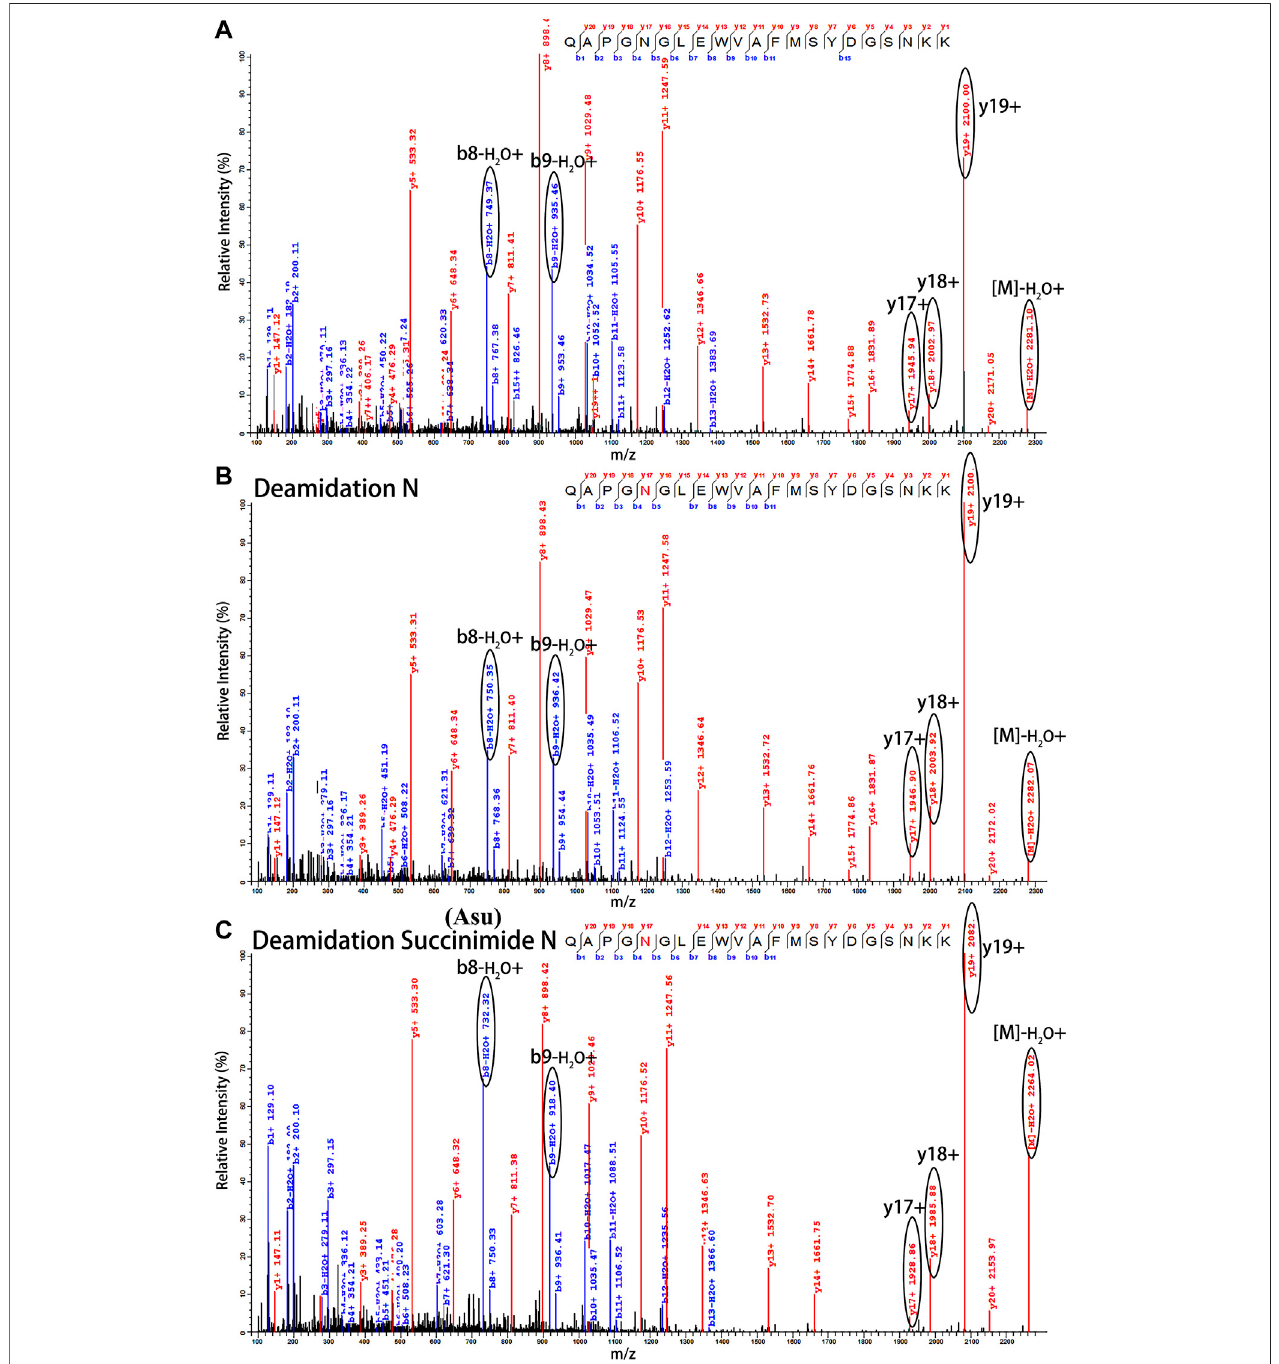
FIGURE 5 | Identi fi cation of Asu modi fi cation in the FR of golimumab. MS/MS spectra of precursor ions at (A) m/z of 767.0142 for native peptide HC: H4-5 (QAPGNGLEWVAFMSYDGSNKK) and (B) m/z of 767.3643 for deamidation and (C) m/z of 761.3448 for Asu. Fine mapping and analysis by a mass spectral peak- labeling software (pLabel ™ ) (Li et al., 2005; Wang et al., 2007).